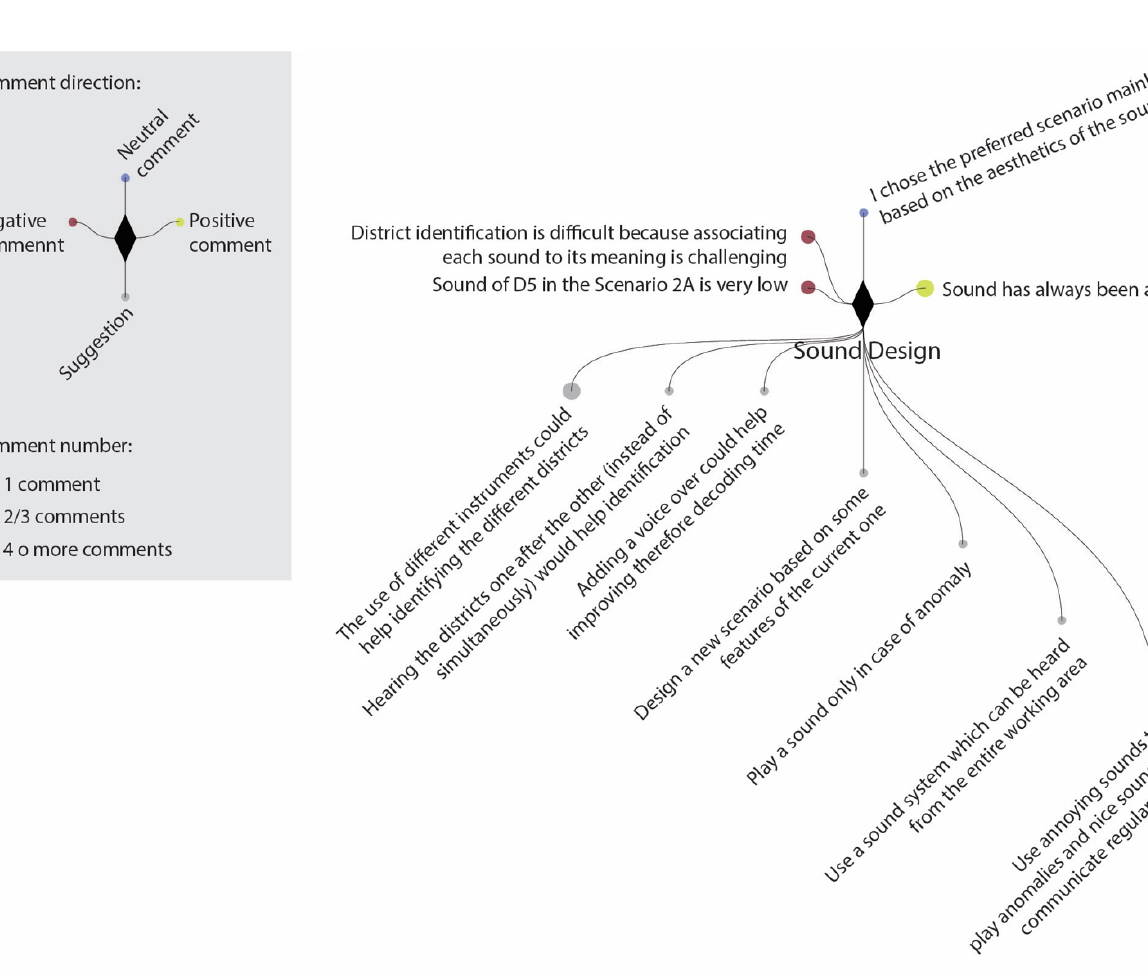
Figure 4 . Analysis of qualitative